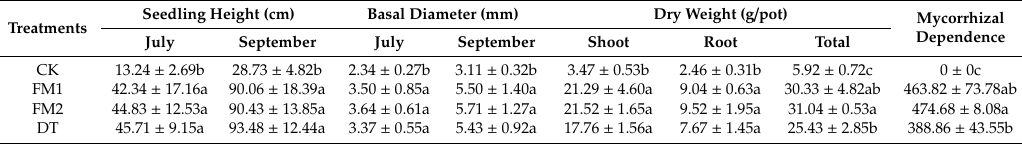
Table 1. E ff ects of arbuscular mycorrhizal fungi (AMF) on G. sinensis seedling growth, biomass and mycorrhizal